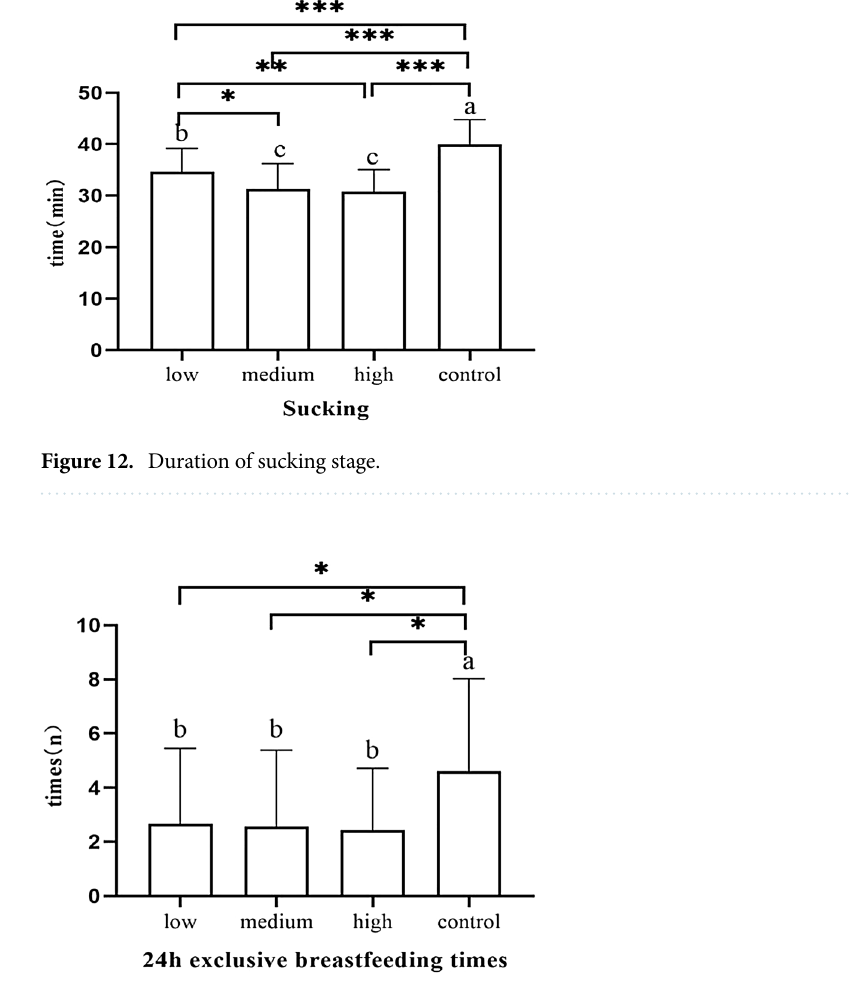
Figure 13. The number of exclusive breastfeeding sessions of 24 h.